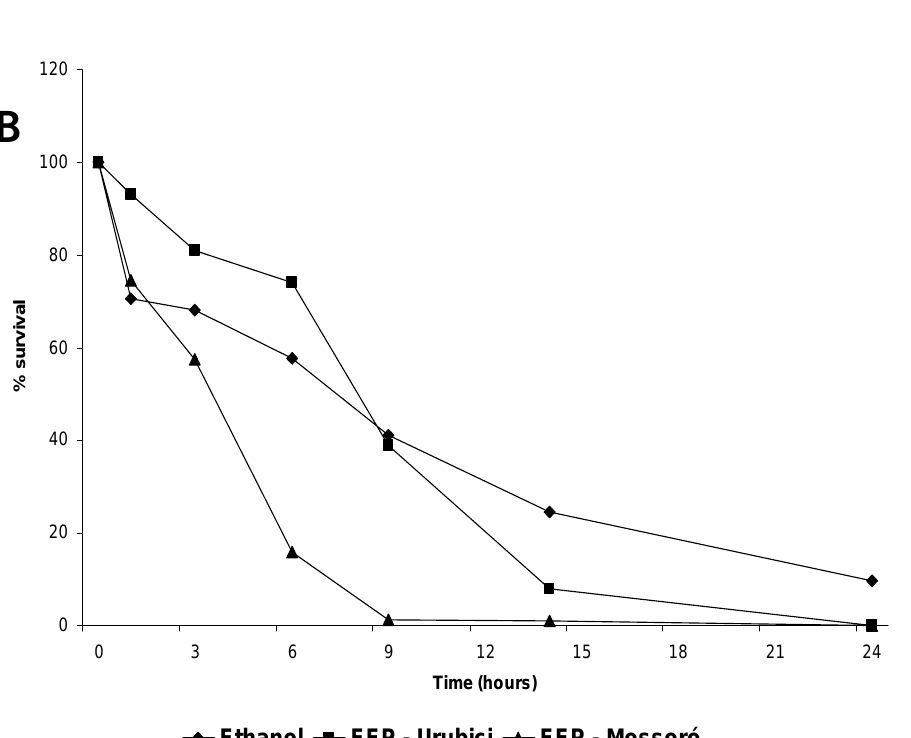
Figure 1. Profile in time of the Population Analysis (A) and Survival Curve (%Cfu/mL) (B) of Salmonella enteritidis according to the incubation period in EEP (10.0%v/v) and 70% Ethanol (12.6%v/v). X 2 = 17.586; p <